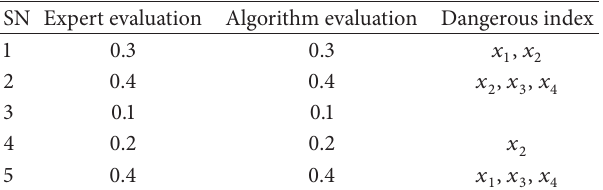
Table 2: The result of the improved BP algorithm. SN Expert evaluation Algorithm evaluation Dangerous index